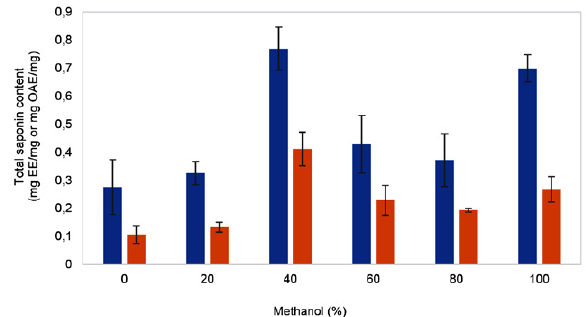
Figure 1. Total saponin content of Eurycoma longifolia fractions collected from solid phase extraction where blue bars are total sap- onin content expressed in milligram escin equivalent per milligram sample (mg EE/mg) and orange bars are total saponin content ex-